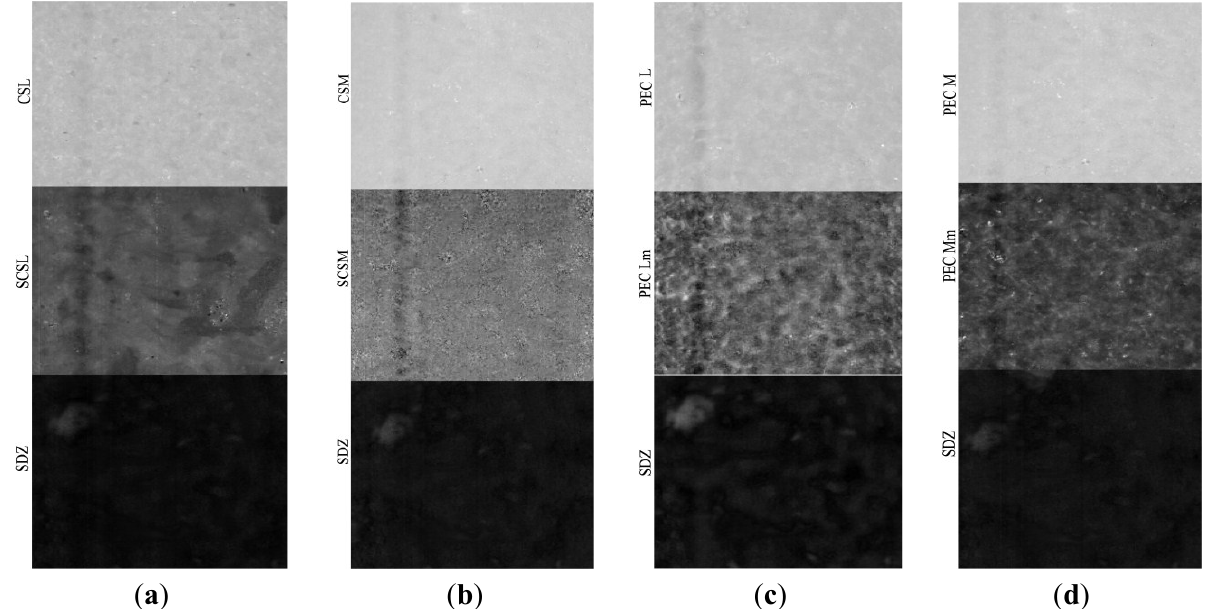
Figure 6. Partial Least Squares-Discriminant Analysis (PLS-DA) model for sulfadiazine (SDZ)-containing systems: ( a ) CSL-SCSL-SDZ (chitosan low molecular